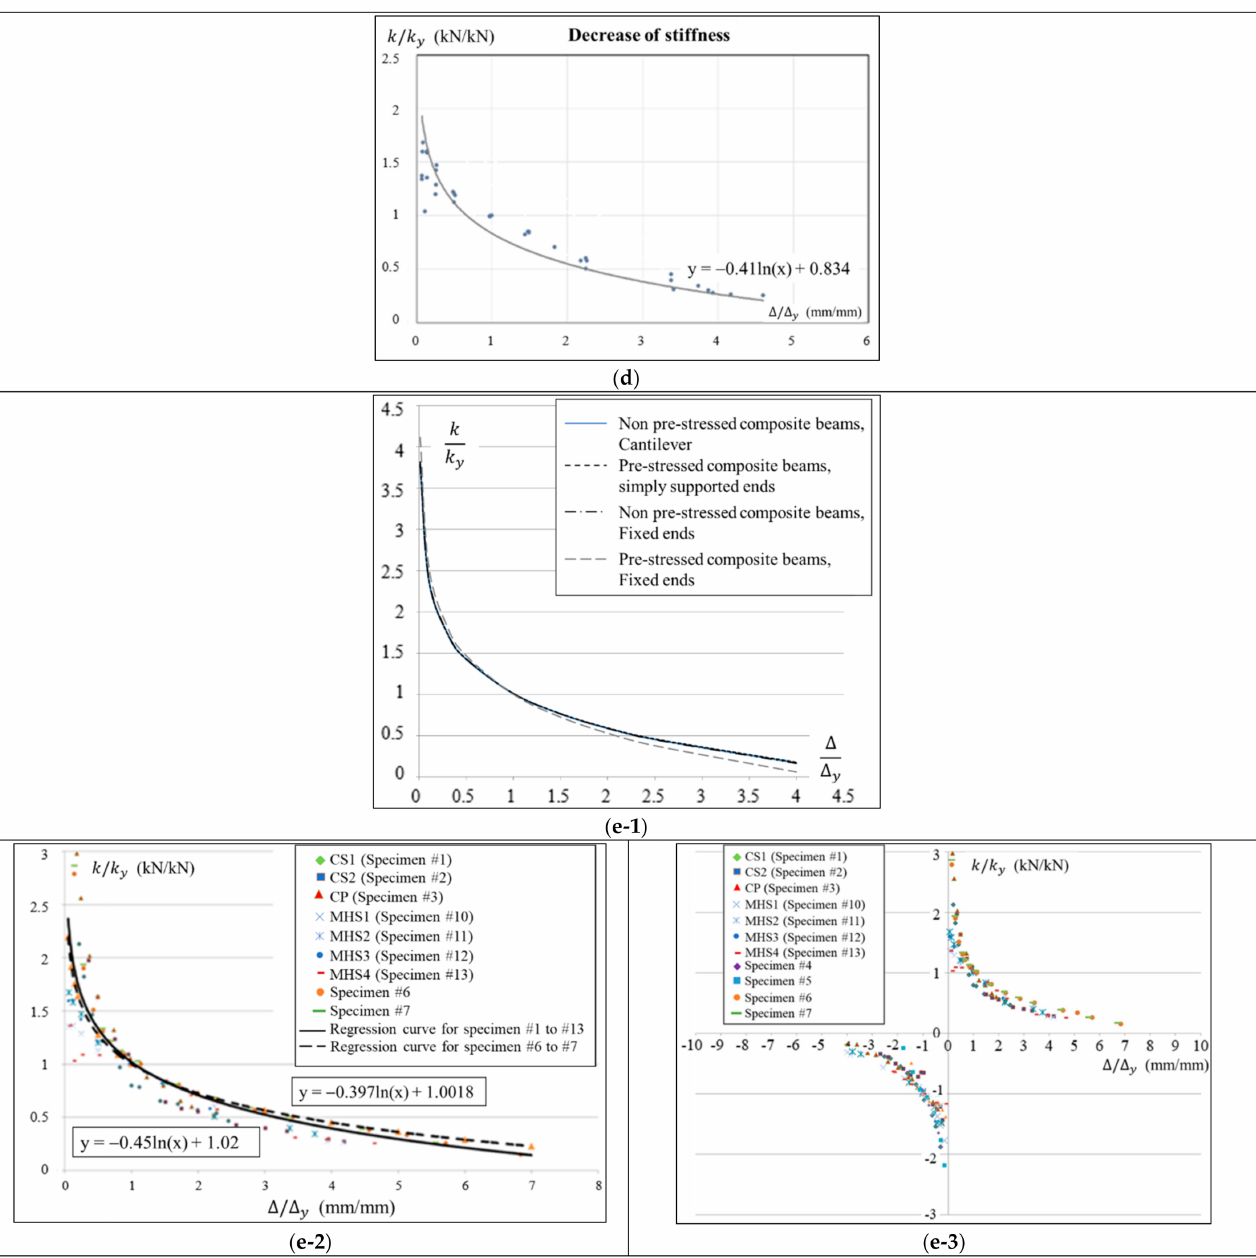
Figure 4. Stiffness degradation tendencies (Specimens #1 to #13). ( a ) Non-pre-stressed cantilever beams (Specimens #1 to #3) for both loading directions [7,26]. ( b ) pre-stressed simply supported beams. (Specimens #4 to #7) [7]. ( c-1 ) pre-stressed fixed-end beams (Specimens #8) [7]. ( c-2 ) non-pre-stressed fixed-end beams (Specimens #9) [7]. ( c-3 ) non-pre-stressed fixed-end beams (Specimens #8 and #9). ( d ) non-pre-stressed composite beams (Specimens #10 to #13) [5]. ( e-1 ) Specimens #1 to #9 [7]. ( e-2 ) All specimens (#1 to #13) vs. Specimens #6 and #7 [25]. ( e-3 ) all specimens